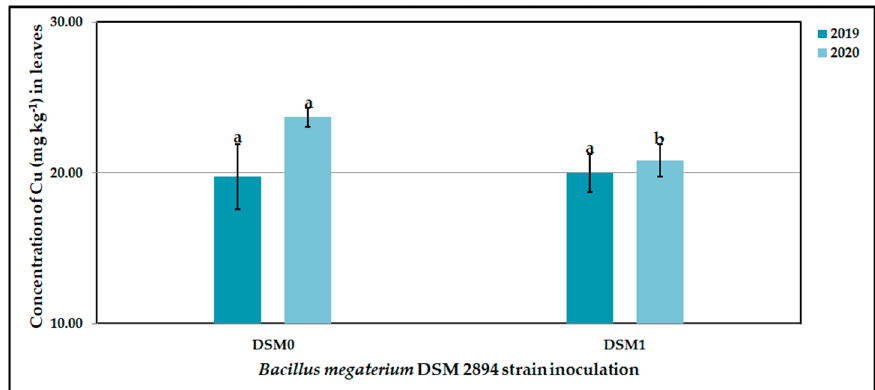
Figure 8. Influence of Bacillus megaterium DSM 2894 var. on leaf copper (Cu, mg kg − 1 ) contents of CaCO 3 ‐ stressed sweet potato plants in 2019 and 2020 seasons. Bars with a different letter indicate significant difference between treatments at p ≤ 0.05. DSM 0 = non ‐ inoculated with Bacillus megaterium DSM 2894 var., DSM 1 = inoculated with Bacillus megaterium DSM 2894 var.